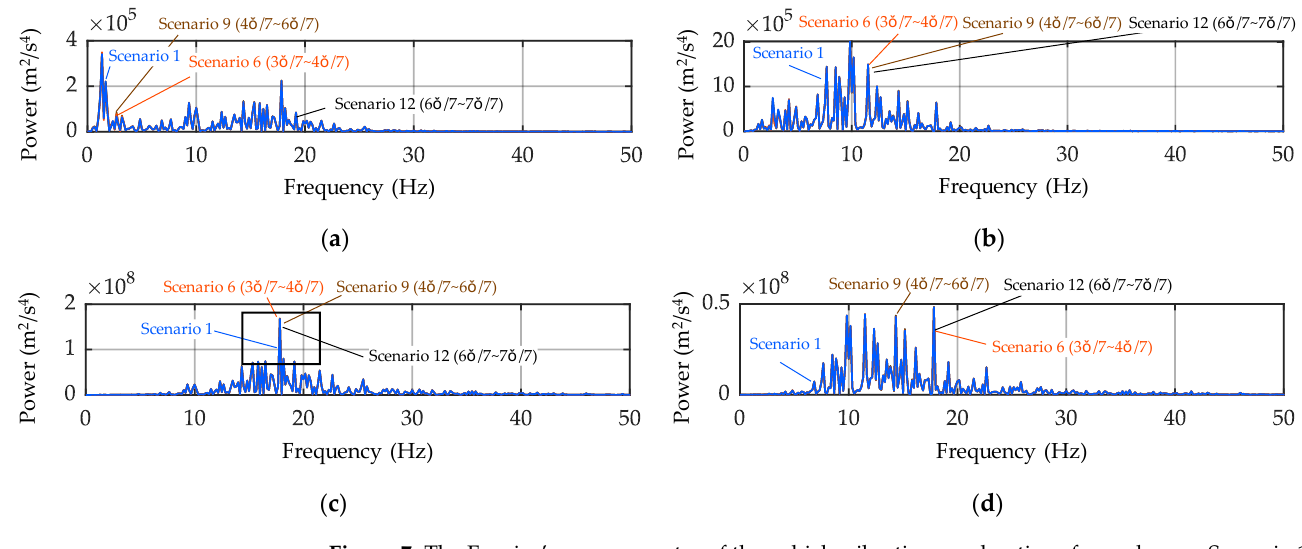
Figure 7. The Fourier’s power spectra of the vehicle vibration accelerations for each case: Scenario 1, Scenario 6, Scenario 9, and Scenario 12: ( a ) 𝑧̈ 𝑠1 ; ( b ) 𝑧̈ 𝑠2 ; ( c ) 𝑧̈ 𝑢1 ; ( d ) 𝑧̈ 𝑢2 . The differences between